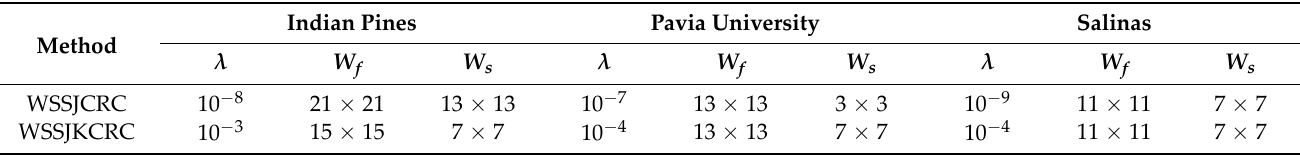
Table 3. Optimal parameter settings for the proposed WSSJCRC and WSSJKCRC methods on the